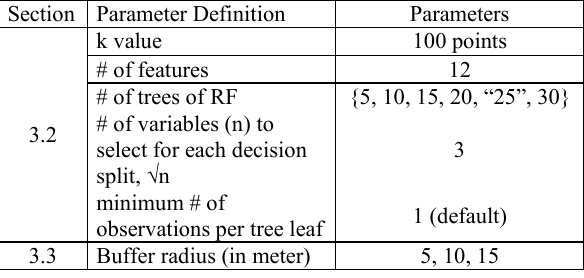
Table 1. Parameter settings.